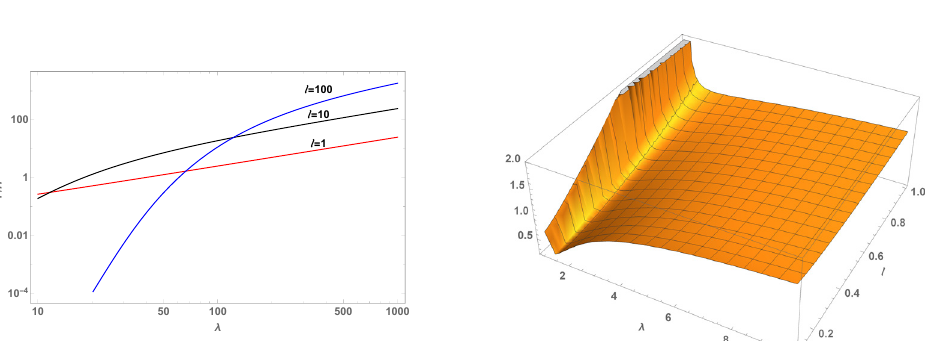
(a) For di ff erent values of (cid:31) , the normalized pair production rate Γ / H 4 is plotted as a function of λ , in the lowest Landau state n = 0 with µ = 1.